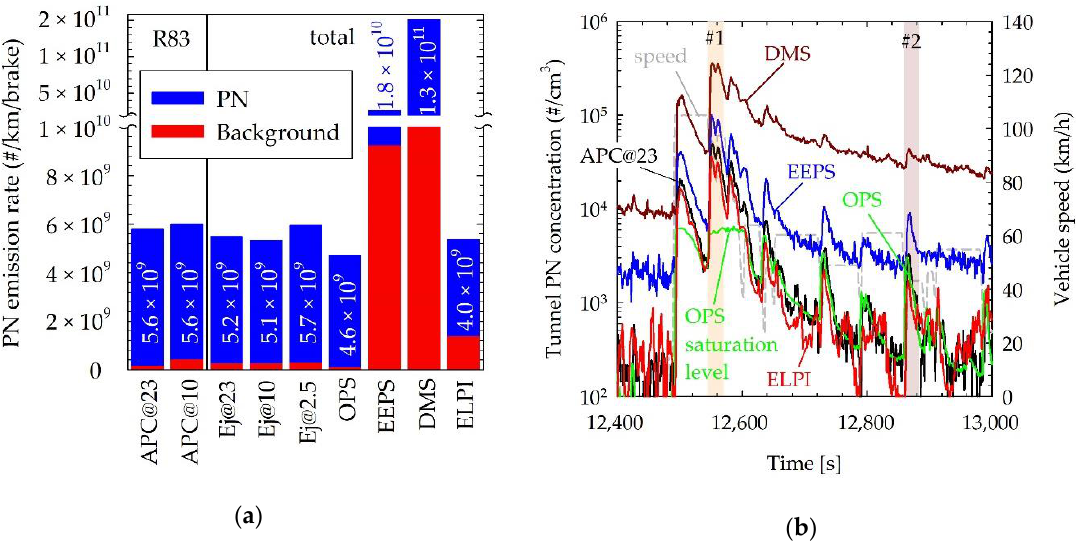
Figure 6. ( a ) Cycle-average PN emissions over a WLTP test with ECE#1 pads with different instruments. Numbers in each bar correspond to the background-corrected PN emissions. The default inversion matrix has been used for the TSI Engine Exhaust Particle Sizer (EEPS), while Dekati Electrical Low Pressure Impactor plus (ELPI) concentrations were determined assuming an effective particle density of 1 g/cm 3 ; ( b ) comparison of the real time traces of APC@23, TSI Optical Particle Sizer (OPS), EEPS, ELPI and Cambustion Fast Particulate Analyser (DMS) over a section of segment 10 of the test.